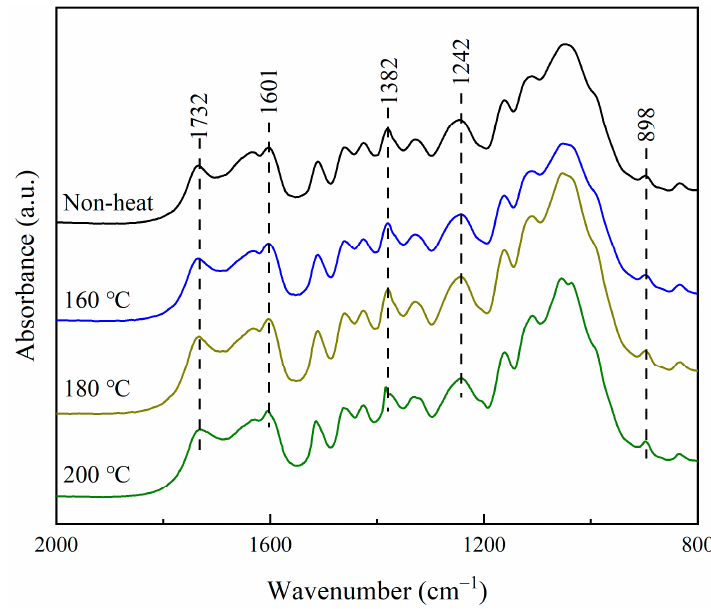
Figure 1. FT-IR spectra of the untreated and treated bamboo.